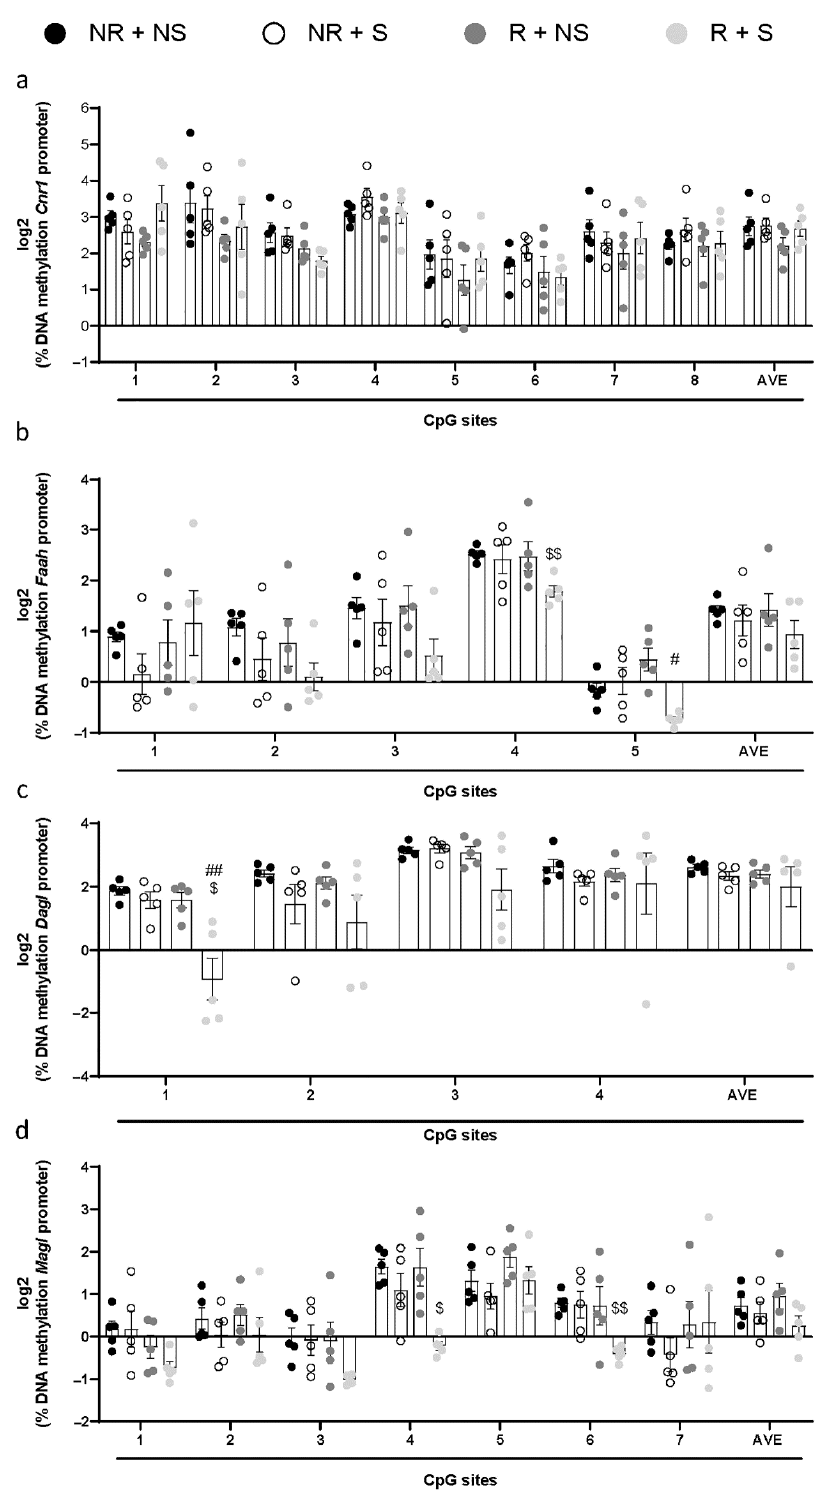
Figure 3. Amount of methylated DNA at Cnr1 ( a ), Faah ( b ), Dagl ( c ), and Magl ( d ) promoter regions in the hypothalamus. Values on the y -axis represent, in log2 scale, the % of methylation values of individual CpG sites under study, as well as of the average (AVE) of all CpG sites ± SEM; n = 5 per group. Data were analyzed by multiple t -test and corrected for multiple comparisons using the Holm–Sidak method. Significant differences are indicated: $ p < 0.05 versus NR + NS, $$ p < 0.01 versus NR + NS, # p < 0.05 versus R + NS, ## p < 0.01 versus R +